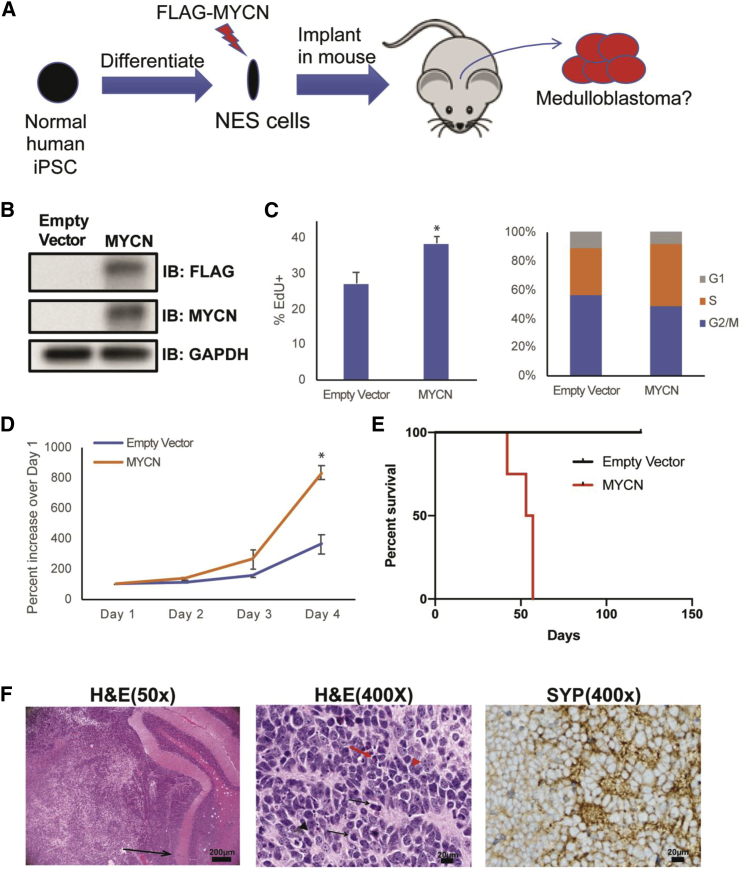
MYCN Drives Transformation of NES Cells to Medulloblastoma(A) Schematic showing differentiation of iPSCs to NES cells, transduction with FLAG-MYCN, and orthotopic implantation into mice.(B) Western blot showing misexpressed MYCN in normal WTC10 NES cells.(C) Empty vector and MYCN NES cells were treated with 5-ethynyl-2′-deoxyuridine (EdU) for 1 h and analyzed via flow cytometry. MYCN NES cells show increased EdU incorporation and S-phase fraction. Data are presented as mean ± SEM; ∗p < 0.05 (t test).(D) CyQuant Direct cell proliferation analysis showing increased proliferation in MYCN NES cells. Data are presented as mean ± SEM; ∗p < 0.05 (t test).(E) Kaplan-Meier survival curve of mice injected with empty vector and MYCN NES cells (n = 4). p = 0.004 (log-rank test).(F) (Left) Low magnification (50×) of H&E staining of WTC10 MYCN tumors showing implanted MYCN NES cells expanding and distorting the mouse cerebellum and invading down Virchow-Robin spaces (arrow). (Middle) High magnification (400×) of H&E staining revealing anaplastic features including frequent mitoses (arrows), cell-cell wrapping (black arrowhead), prominent nuclei (red arrowhead), and karyorrhexis (red arrow) characteristic of large cell and/or anaplastic medulloblastoma. (Right) Immunohistochemical staining for synaptophysin (SYP) highlighting neuroblastic pseudorosettes. Scale bars represent 200 μm for 50× images and 20 μm for 400× images.See also Figures S1 and S2 and Tables S1, S4, and S6.